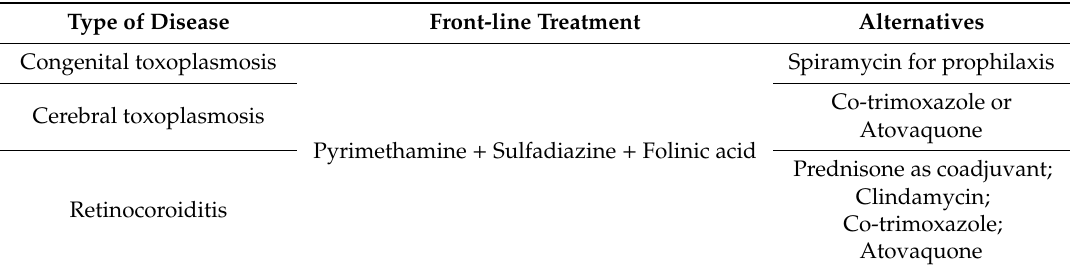
Table 1. Chemotherapeutic approaches commonly used for